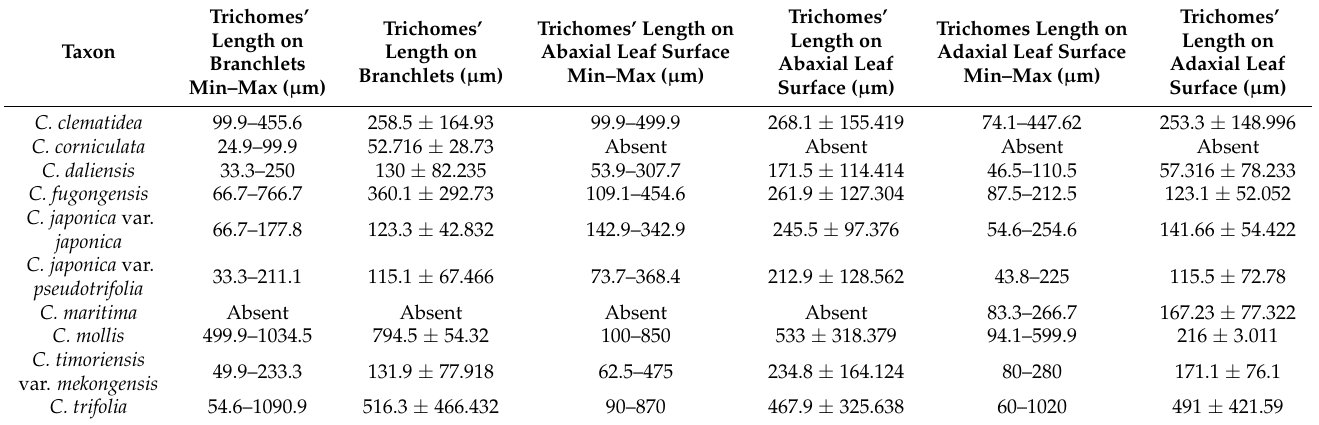
Table 3. Quantitative features of trichomes on branchlets and leaves.